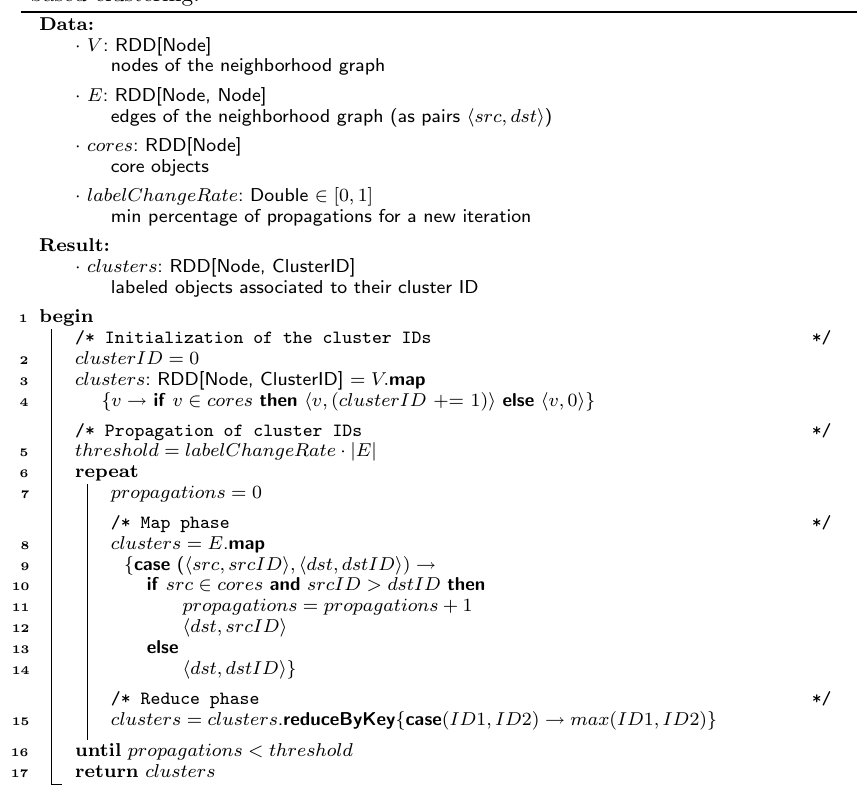
Algorithm 2: findClusters(V,E,cores,labelChangeRate) . Distributed density- based